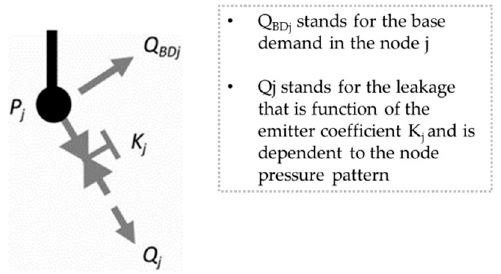
Figure 9. Scheme of the two types of node demands [18].